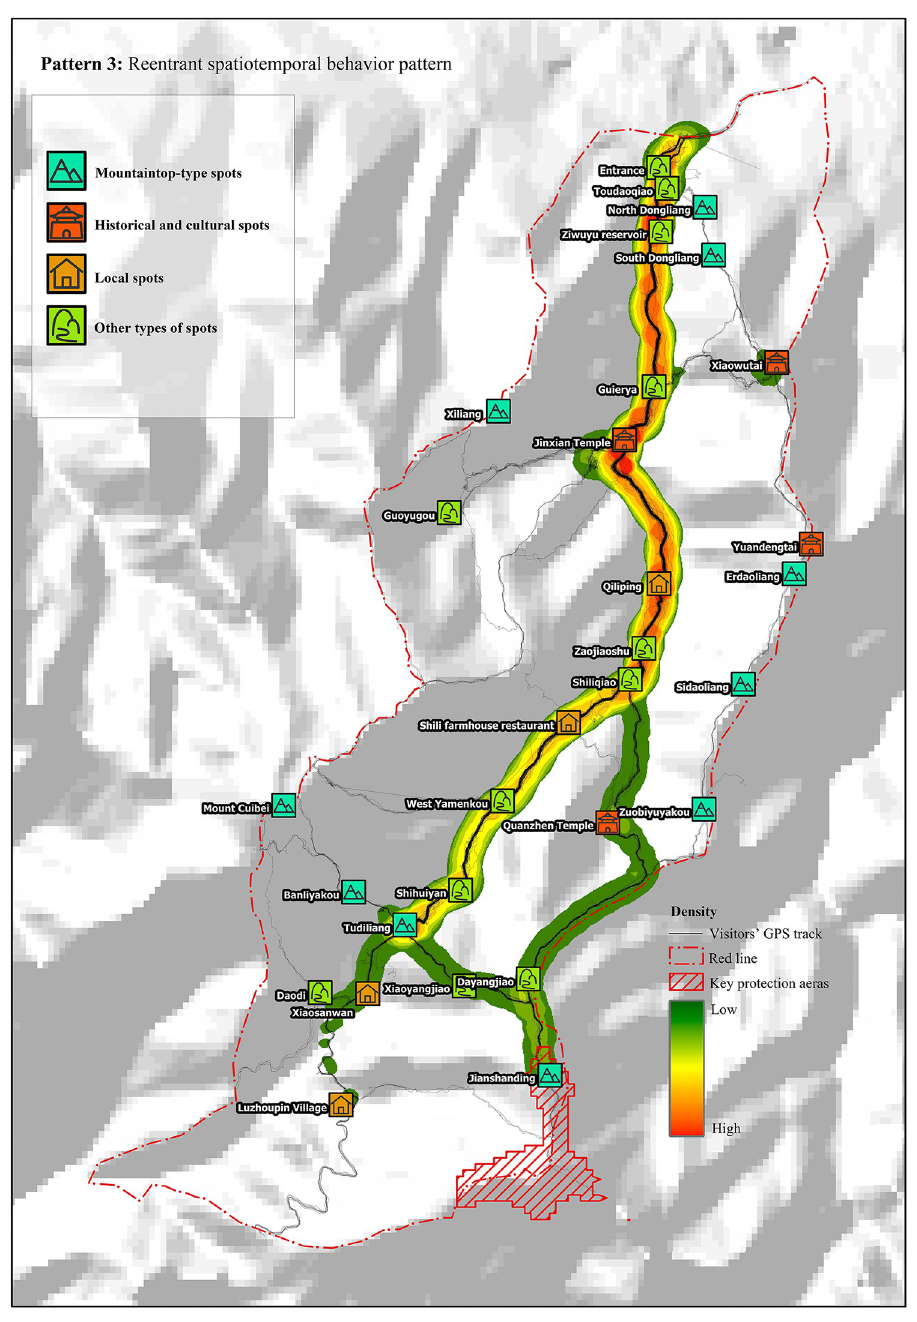
Fig 4. Reentrant spatiotemporal behavior pattern. Reprinted from [https://www.usgs.gov/centers/eros/data] under a CC BY license, with permission from [United States Geological Survey], original copyright [2000].